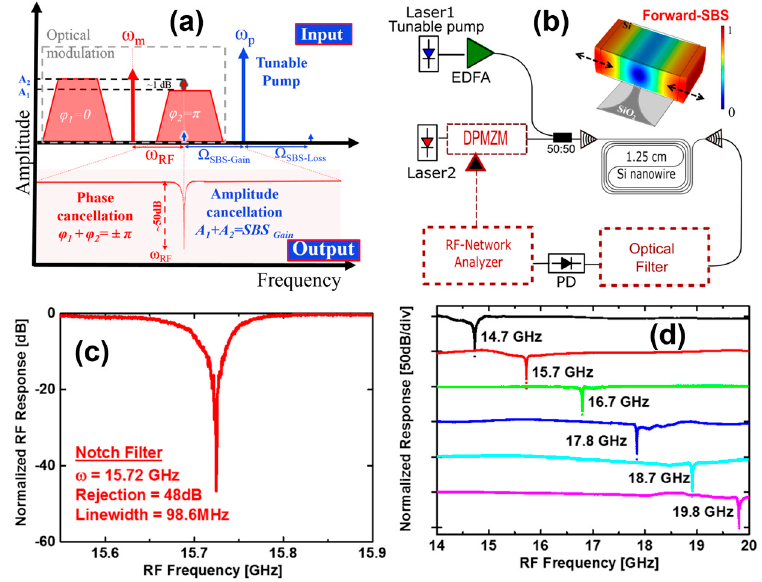
Figure 21. ( a ) Working principle of the MPF created by SBS in [118], ( b ) setup of the notch filter experiment, ( c , d ) Measured notch MPF responses. Courtesy of and adapted from Alvaro Casas-Bedoya [118].